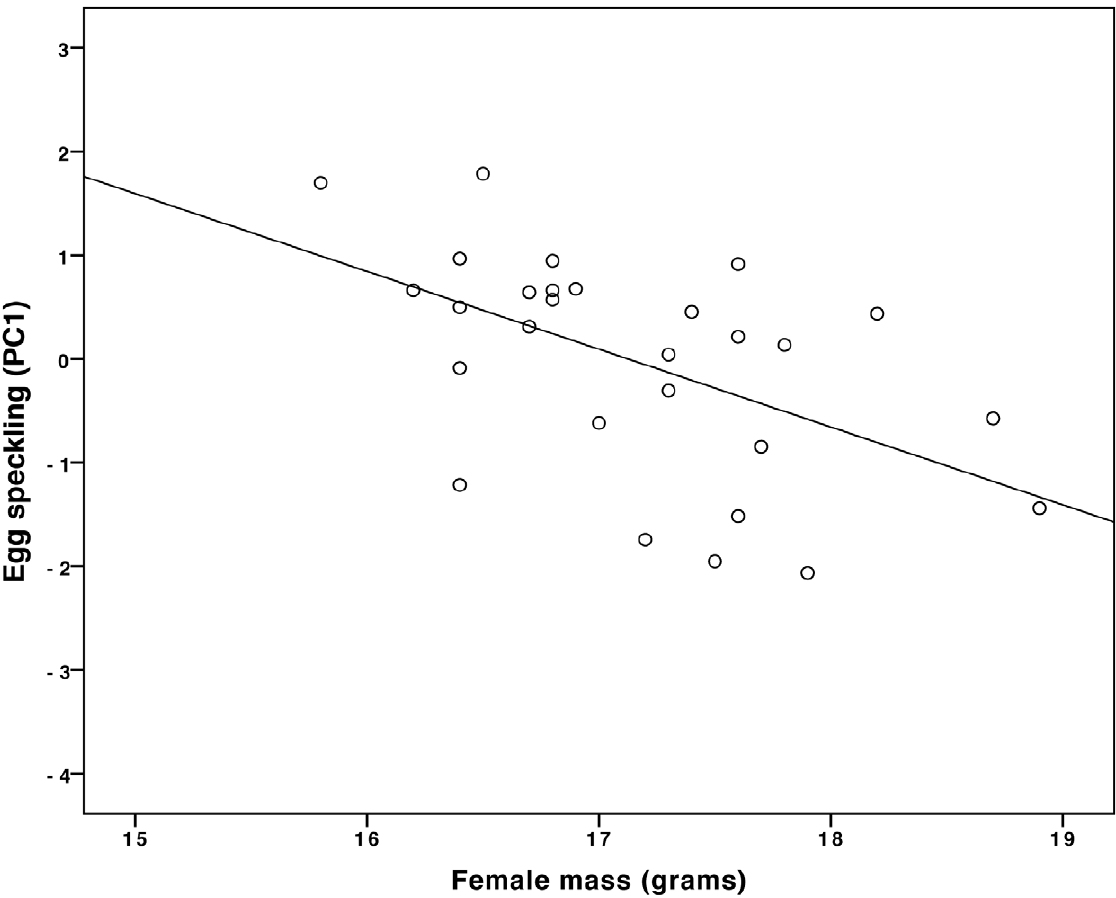
Figure 4. Heavier females laid less speckled eggs (PC1). N=28 nests (see text for statistics).